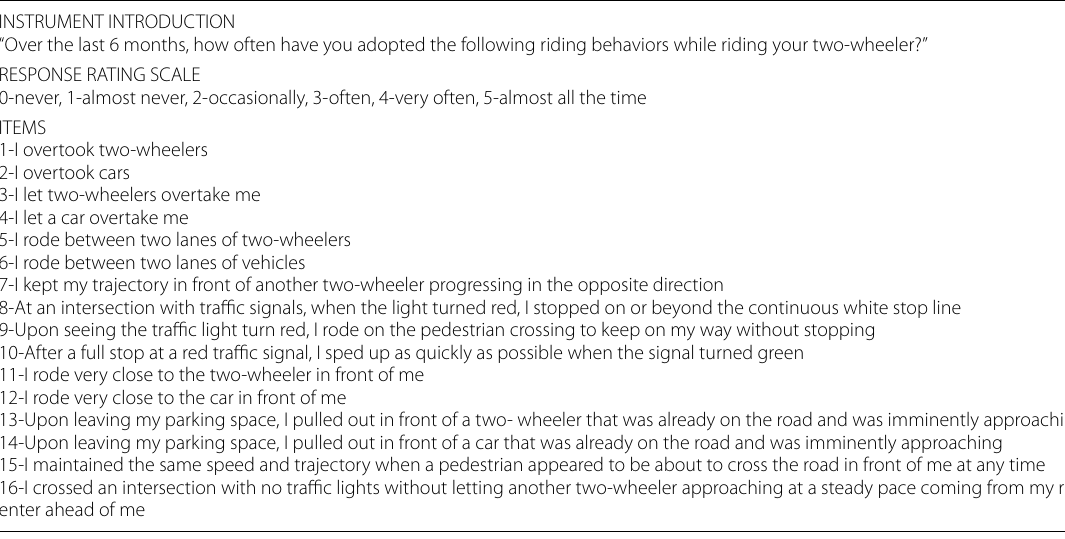
The original Chinese version is available from the first author upon request